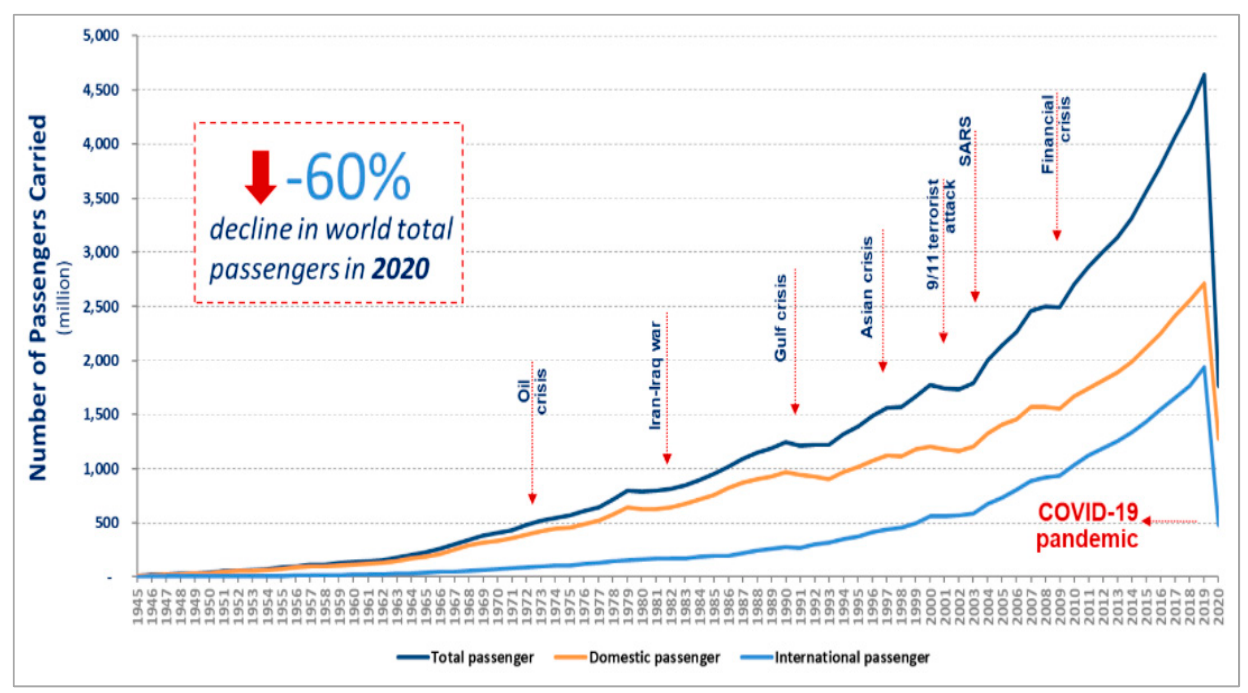
Figure 4. Global air passenger traffic trend, 1945–2020 (source: International Civil Aviation Organization [53]).